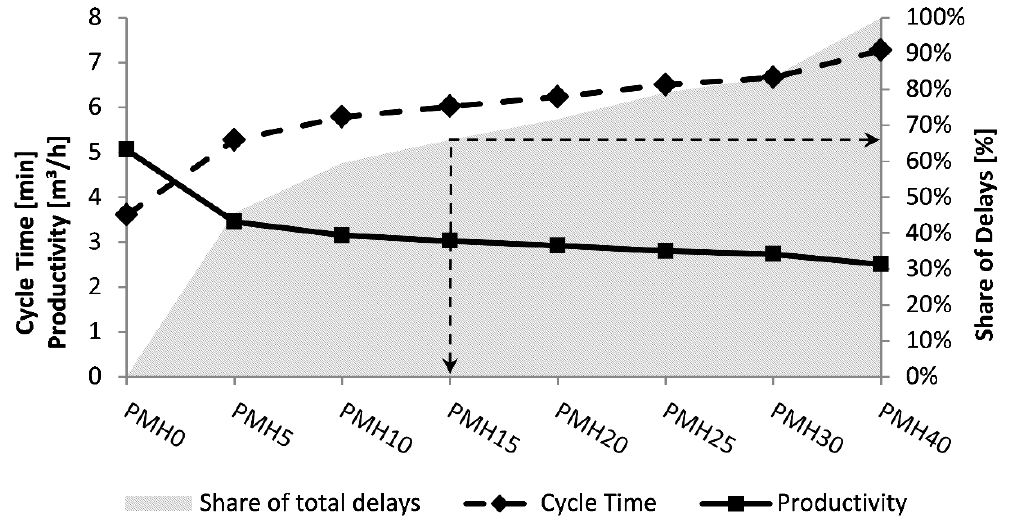
Figure 5. Performance indicators according to added delays, with performance rated through cycle time (min) and productivity (m³/h) on the left y -axis in dependence of different delay time threshold additions on the PMH on the x -axis and the overall coverage of delay times experienced in this study on the right y